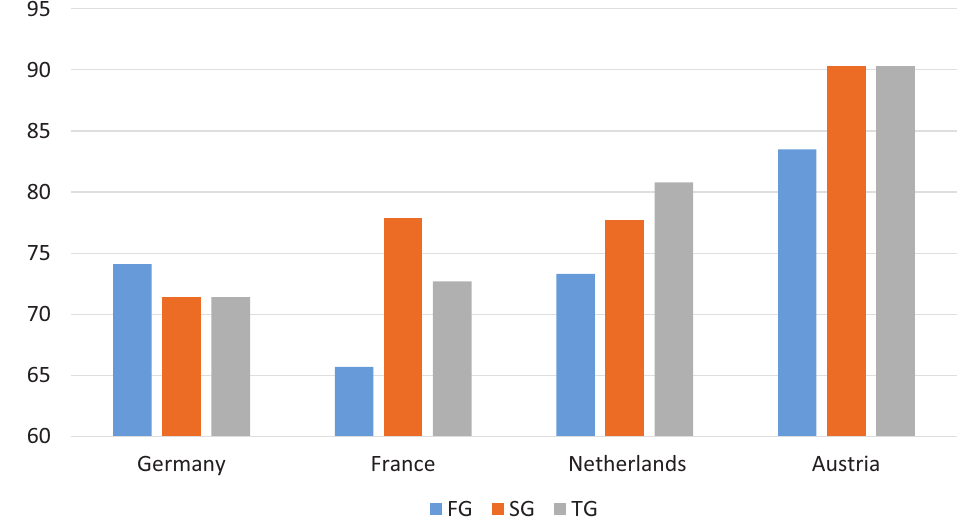
Figure 1. Percentage of individuals reporting to have good and very good general health by generation and by